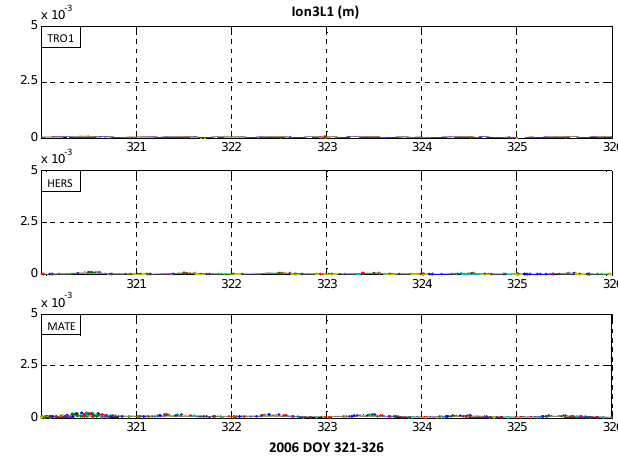
Fig.12. Ion2 (m) for GPS L1 (Ion2L1) for the three observation stations on 321‐326 in 2006. Fig. 12. Ion2 (m) for GPS L1 (Ion2L1) for the three observation stations on 321–326 in 2006.